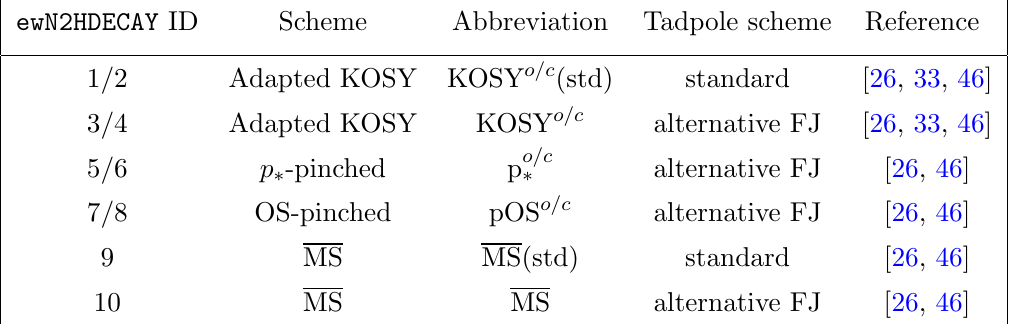
Table 3 . Renormalization schemes of ewN2HDECAY [35]. For further explanations, we refer to the